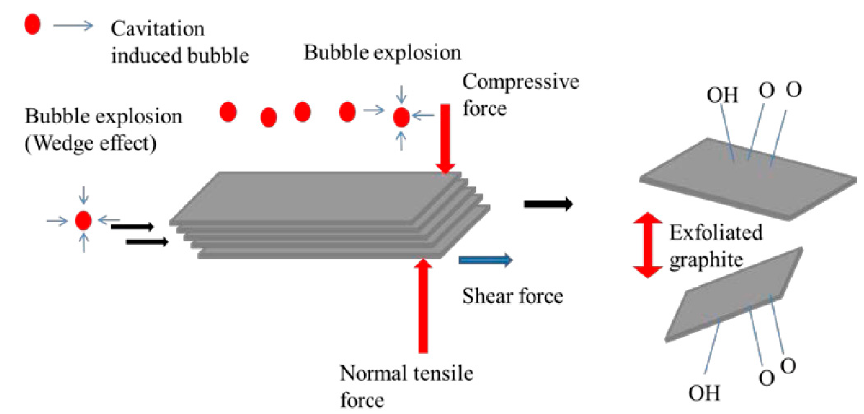
Figure 5. Illustration of the possible mechanism of graphite exfoliation. Reproduced from